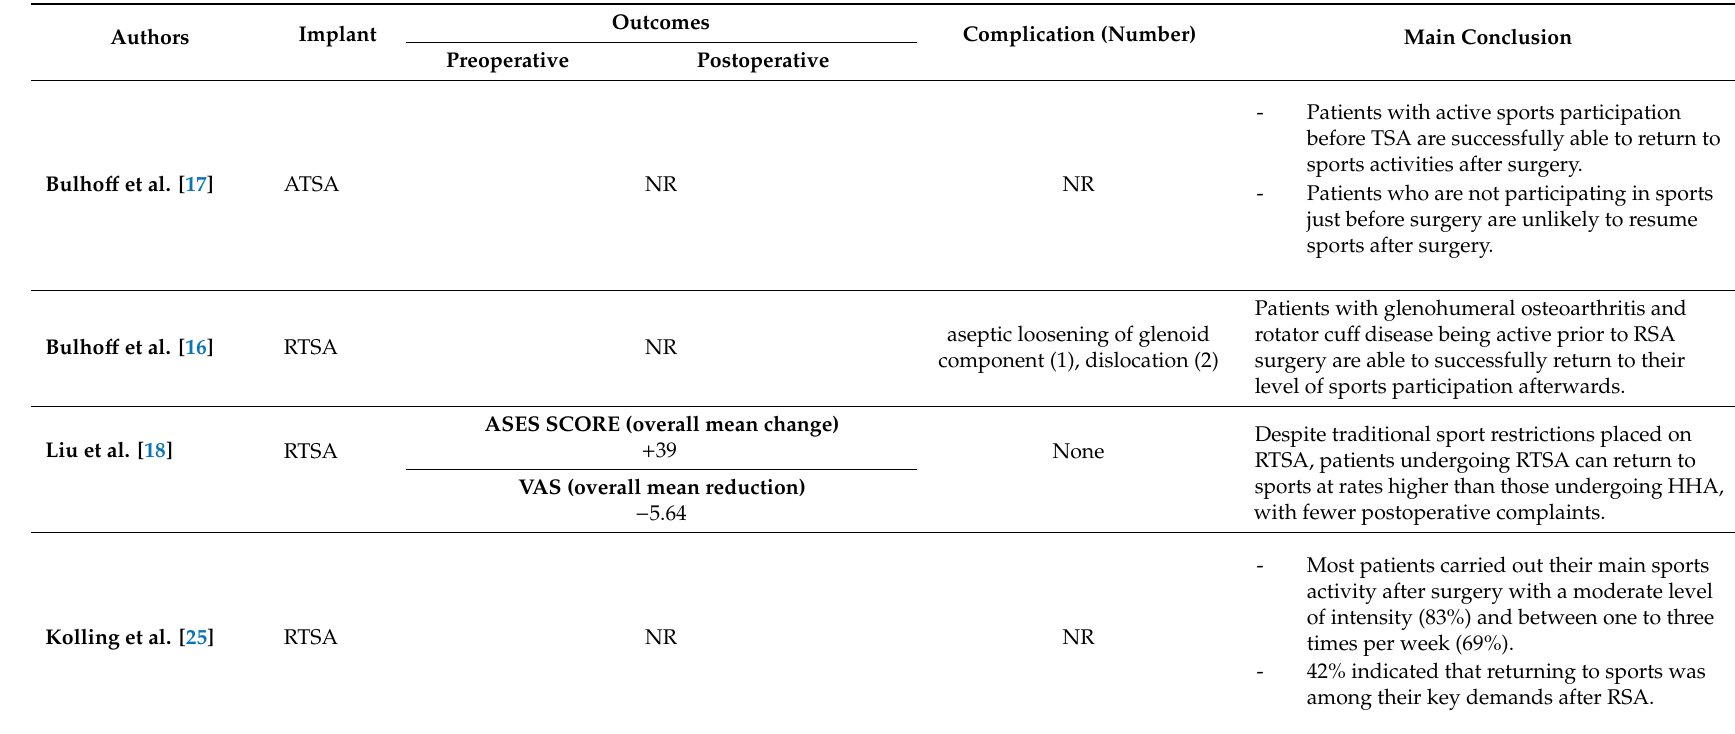
Table 3. Clinical outcome data of the included